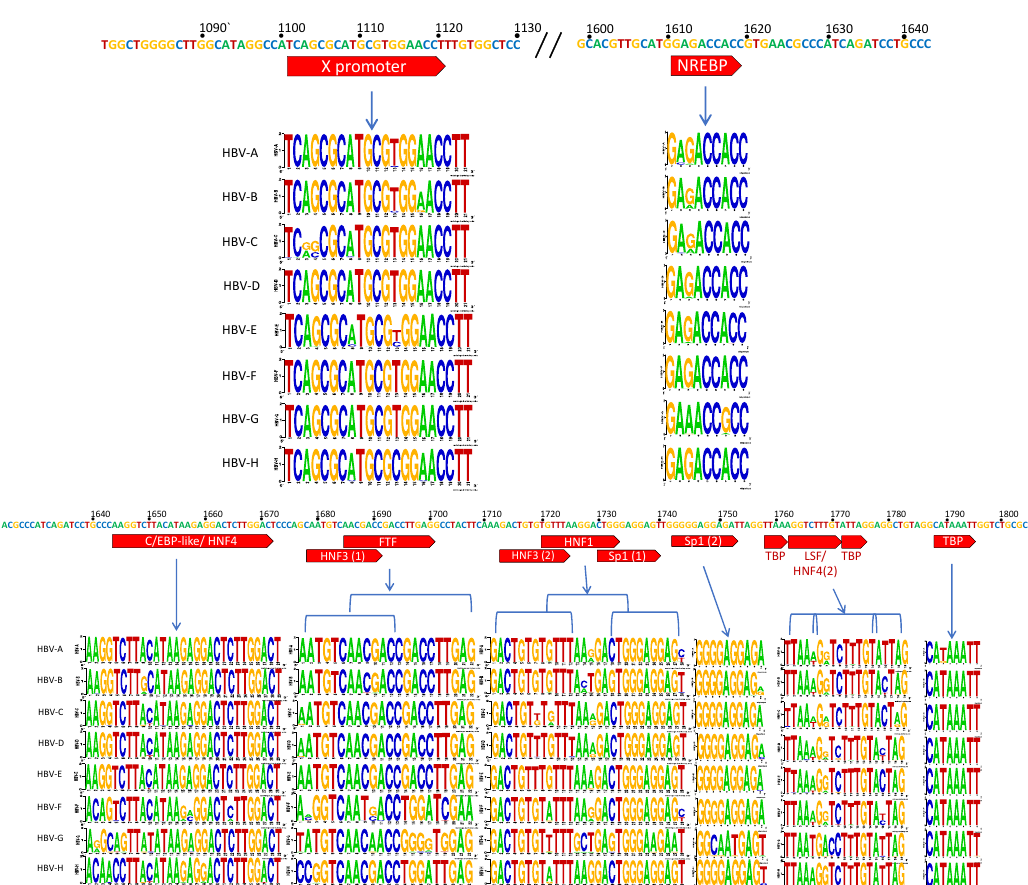
Figure 2. HBV X and Core promoter regions. Upper bar represents the consensus sequence across all genotypes. Highlighted segments refer to previously identified binding sites for various host proteins. Stacked LOGO sequences are displayed per genotype to give a pictorial representation of conserved nucleotides and variants. The complete consensus for the core promoter (nts 1613–1849) is included